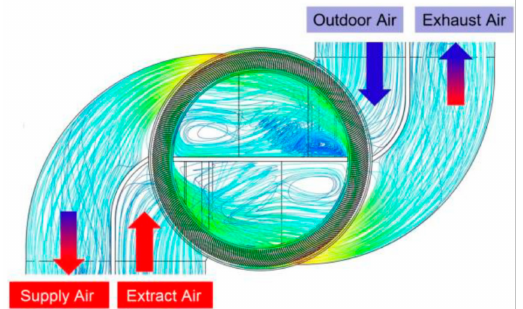
Figure 7. Concept of the Counter flow Heat Recovery Fan. Cross section of the flow conduction